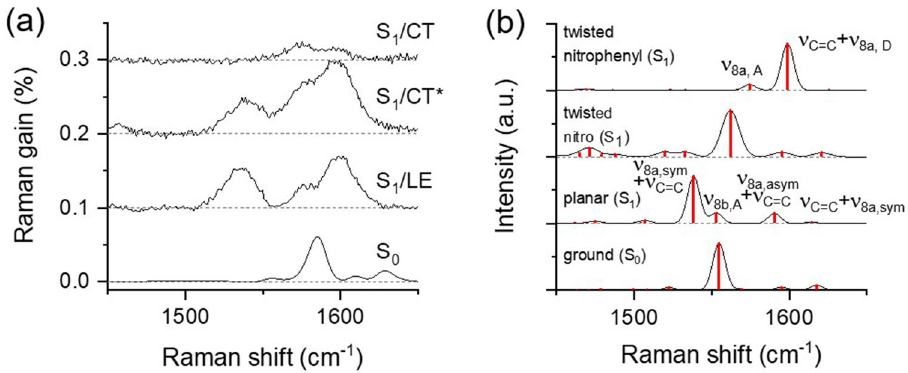
Figure 6. ( a ) Femtosecond stimulated Raman spectra of DNS in CHCl 3 solution with 403 nm excitation. Each spectrum representing the S 1 /LE, S 1 /CT*, and S 1 /CT state was obtained at the time delays of 0.0, 0.9, and 9.9 ps. ( b ) simulated Raman spectra of DNS in the ground state, and the S 1 excited states with the planar, twisted nitro, and twisted nitrophenyl geometry. Approximate bandwidths of 10 cm −1 were used for the simulated Raman